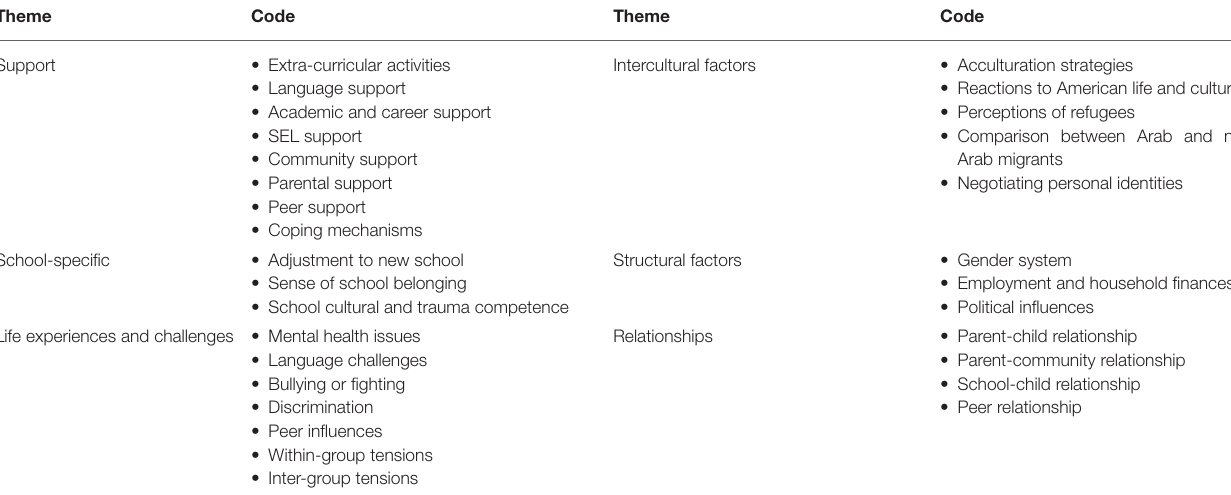
TABLE 2 | Primary thematic codes analyzed.